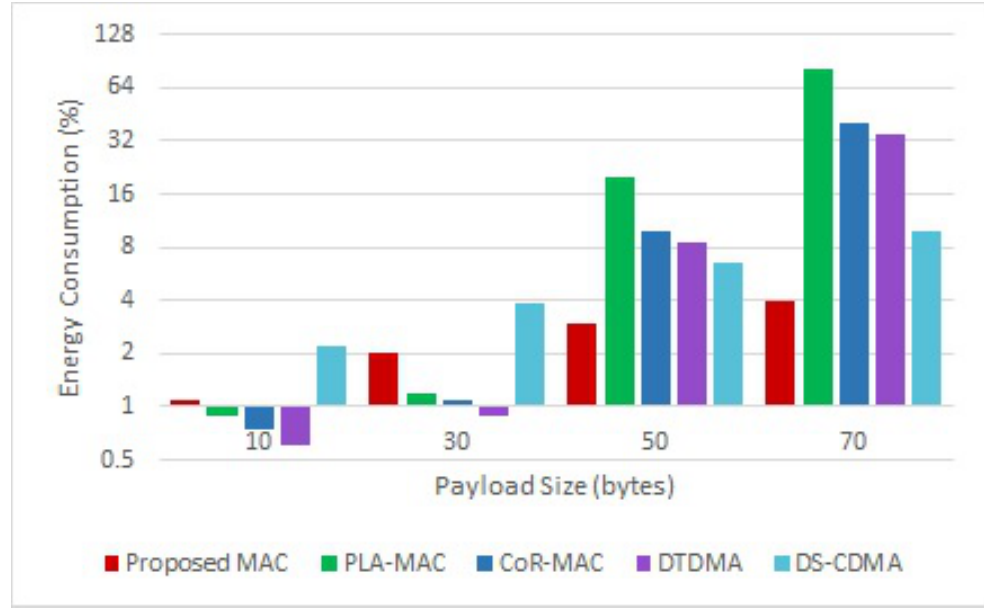
Figure 9. Energy Consumption for Varying Payload